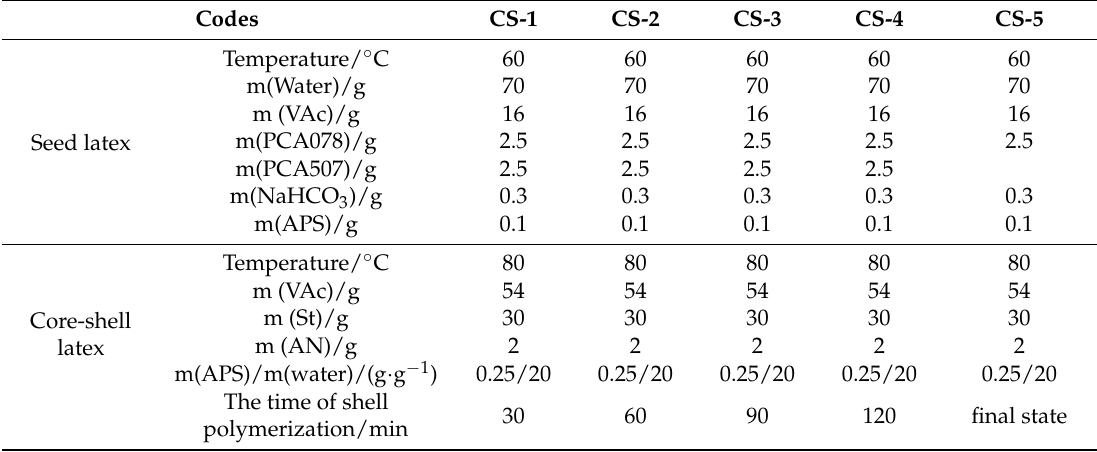
Table 1. Recipes and reaction conditions for synthesizing polyvinyl acetate (PVAc)-acrylonitrile (AN)/polystyrene (PS)